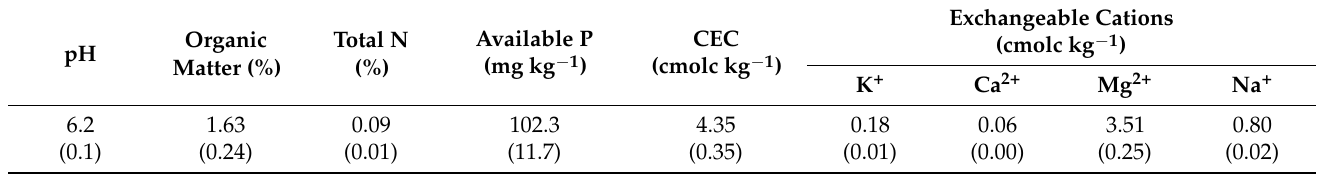
Table 1. Characteristics of nursery soil used in the